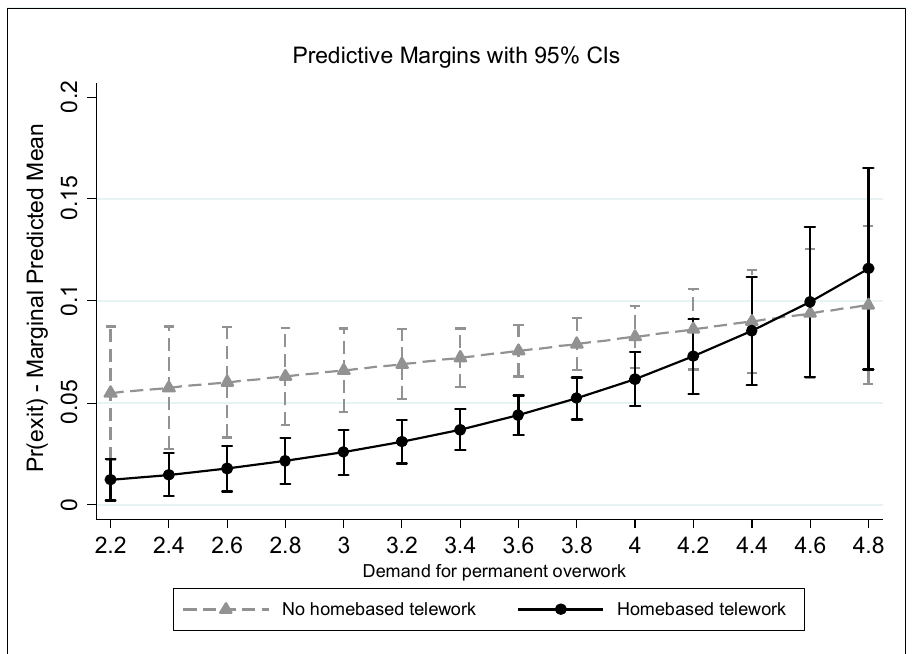
Figure 1. Predictive margins of the association between the perceived availability of home-based teleworking and voluntary employee exit moderated by a highly demanding culture. Note. Predictive margins of the known availability of home-based teleworking and a highly demanding culture with 95% confidence intervals (Cis) using stata are based on the mixed-effects regressions in Table 3.